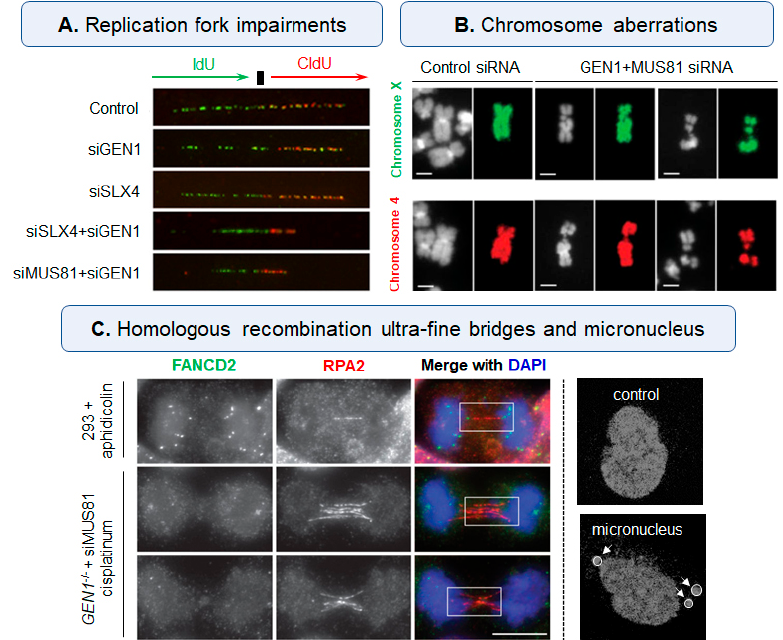
Figure 3. Typical damage caused by unsolved-HJ in nucleases-deficient cells. ( A ) Combined depletion of SLX4-GEN1 or MUS81-GEN1 slowed the progression of replication fork using DNA fiber assay, fibers were stained with IdU (green) and CldU (red) antibodies to represent the replication fork progress. ( B ) Combined depletion of MUS81-GEN1 in BS patient cells induced serious chromosome breakages (sained with DAPI in chromosomes X and 4). ( C ) Combined depletion of MUS81-GEN1 increased homologous recombination ultra-fine bridges (HR-UFBs) in cisplatinum-treated cells compared with normal 293 cells treated with aphidicolin (HR-UFBs were stained with RPA2 and FANCD2), and HJ-ligand induced micronucleus in cancer cells [20,82,84,86].